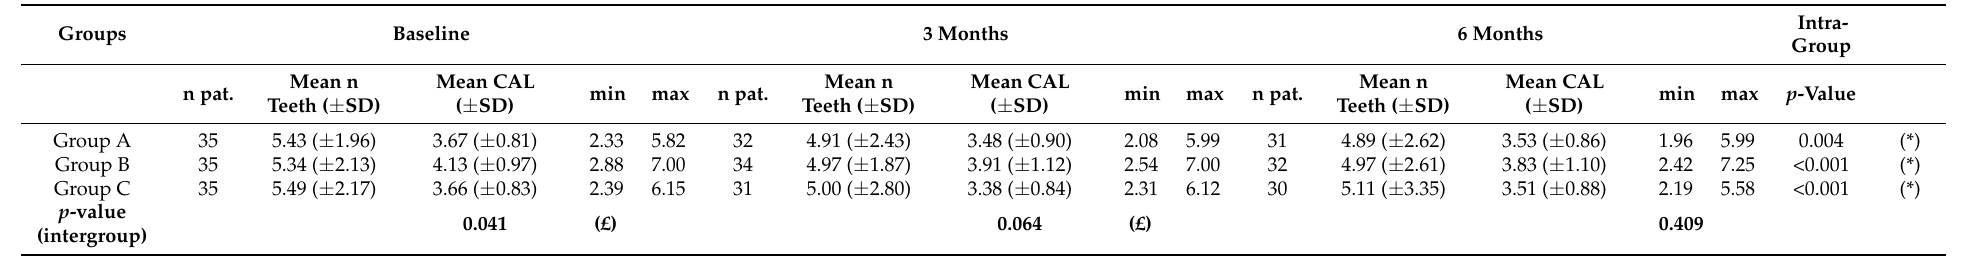
Table 5. Clinical attachment level (mm) ± SD per tooth in the three treatment groups (A: PDT, B: LDD, C: control) at baseline and after 3 and 6 months). Groups